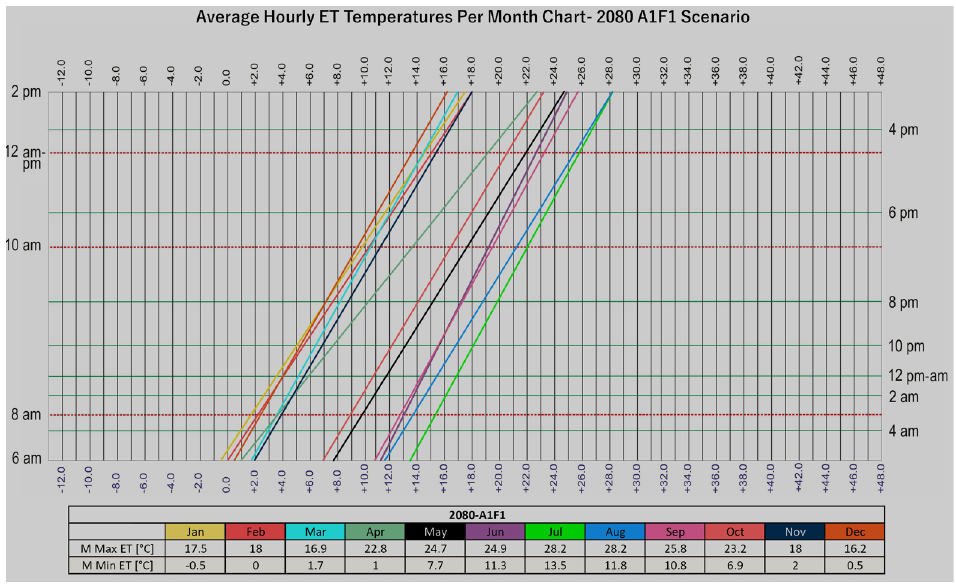
Fig. 1. Hourly ET Production Process Example – 2080